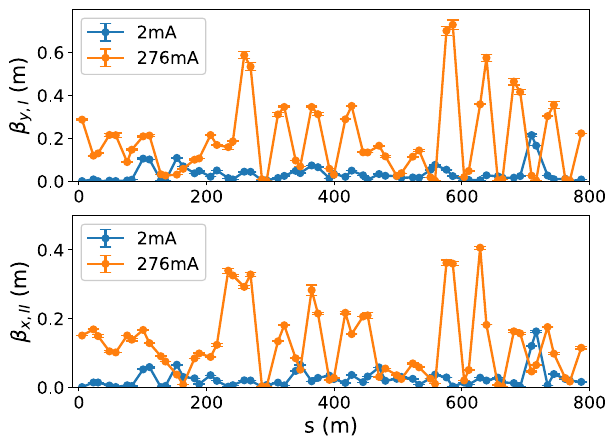
FIG. 14. Comparison of two coupling β -functions at a low beam current (2 mA) and at a higher beam current (276